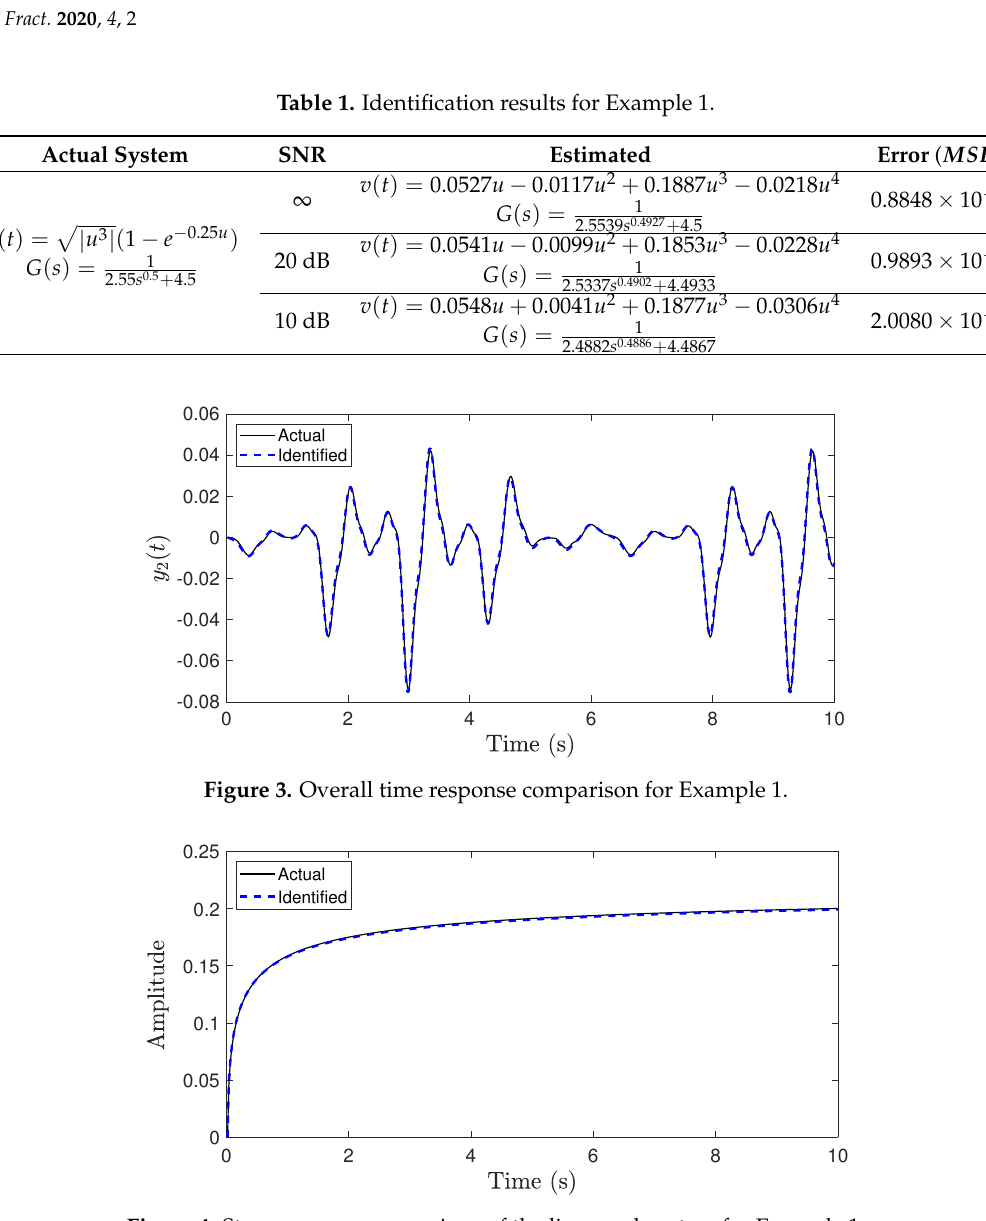
Figure 4. Step response comparison of the linear subsystem for Example 1.